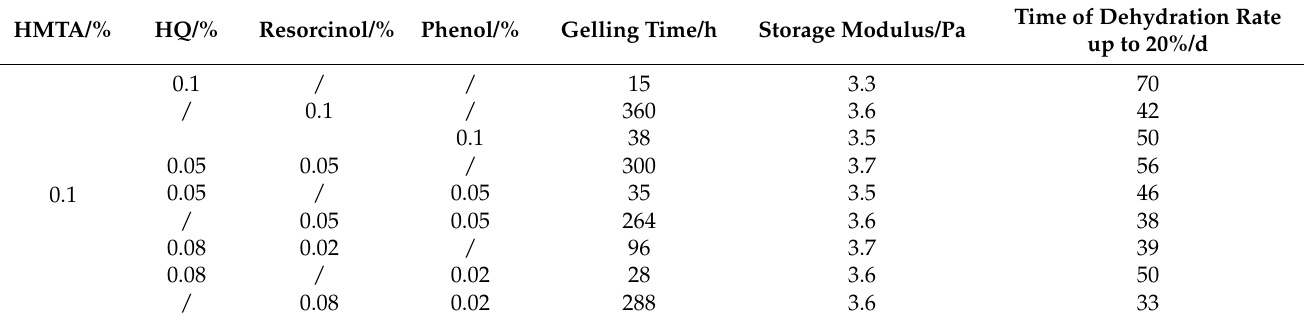
Table 1. The influence of the type of phenol crosslinking agent on gel properties.